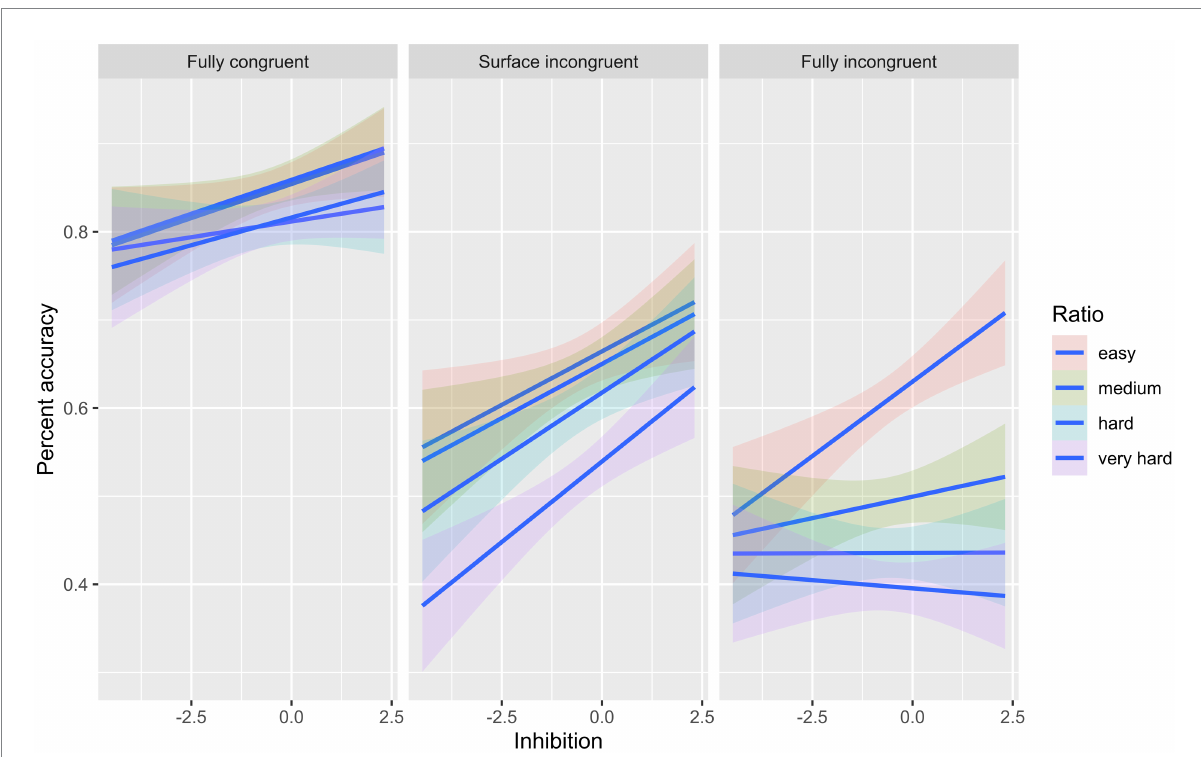
FIGURE 1 Interaction effect between Inhibitory control, type of trial, and ratio on